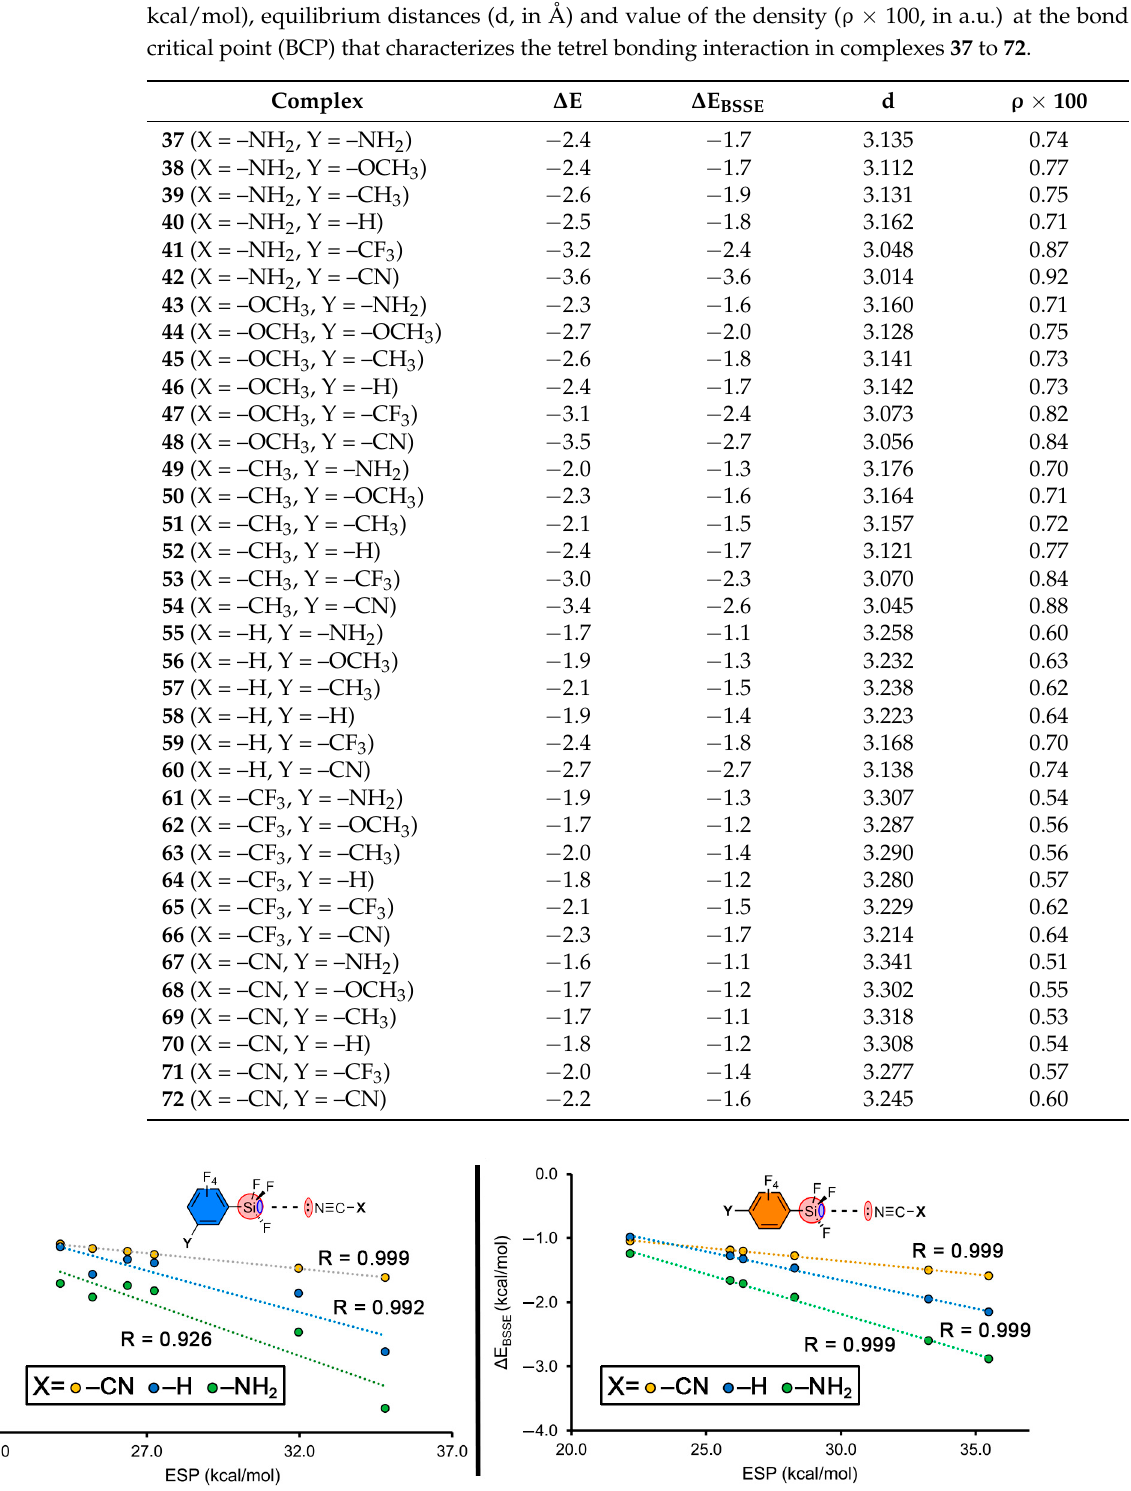
Figure 3. Electrostatic surface potential values (ESP) vs. the BSSE-corrected binding energies ( Δ E BSSE ) of several representative meta- (left) and para-substituted (right) complexes.